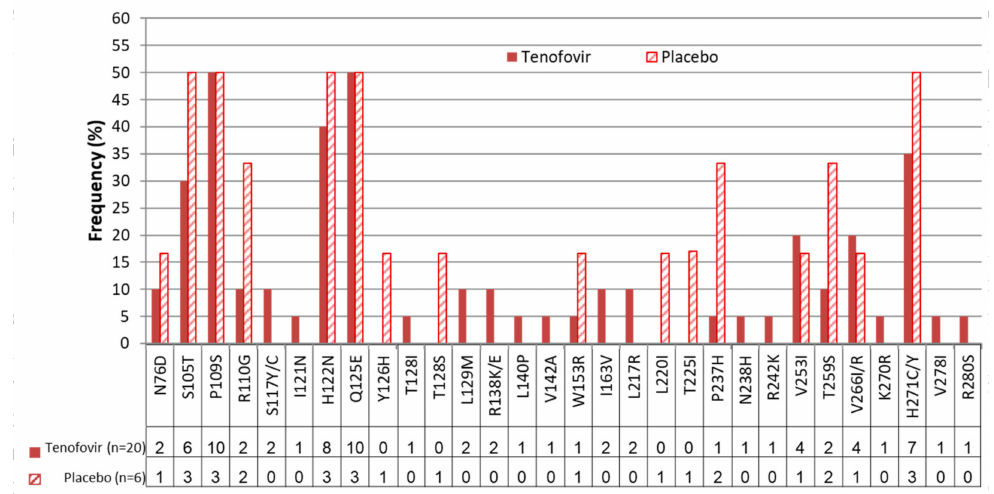
Figure 3. Frequency of the HBVrt domain associated mutations in the tenofovir and placebo isolates. Positions N76, R110, S117, I121, T128, L129, R138, L140, V142, W153, I163, L217, P237, N238,